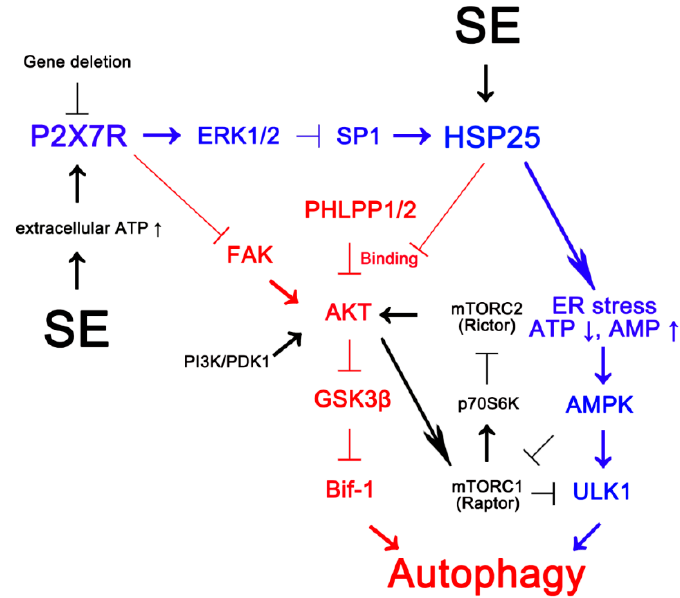
Figure 10. Scheme of inhibitory role of P2X7R in AKT-S473 hyperphosphorylation during astroglial autophagy induced by KA injection based on the present data (red) and previous reports (blue and black) [6,14,21–23]. After KA injection, P2X7R activation inhibits FAK phosphorylation and HSP25 transactivation via ERK1 / 2-mediated SP1-T739 phosphorylation. P2X7R deletion leads to sustained HSP25 expression, which activates AMPK / ULK1-mediated astroglial autophagy (blue) [6]. In addition, P2X7R deletion increases FAK autophosphorylation [20]. Subsequently, the activated FAK phosphorylates AKT, and the prolonged HSP25 expression abrogates the binding of PHLPP1 / 2 to AKT, which result in AKT-S473 hyperphosphorylation. Sustained AKT-S473 phosphorylation exerts AKT / GSK3 β -mediated Bif-1 induction that triggers astroglial autophagy (red), independent of PI3K / PDK1 and mTOR complex (mTORC) 1 / 2 activities (black). Thus, these findings suggest that P2X7R may be a fine-tuner of autophagic process in astrocytes by regulating AKT-S473 phosphorylation.